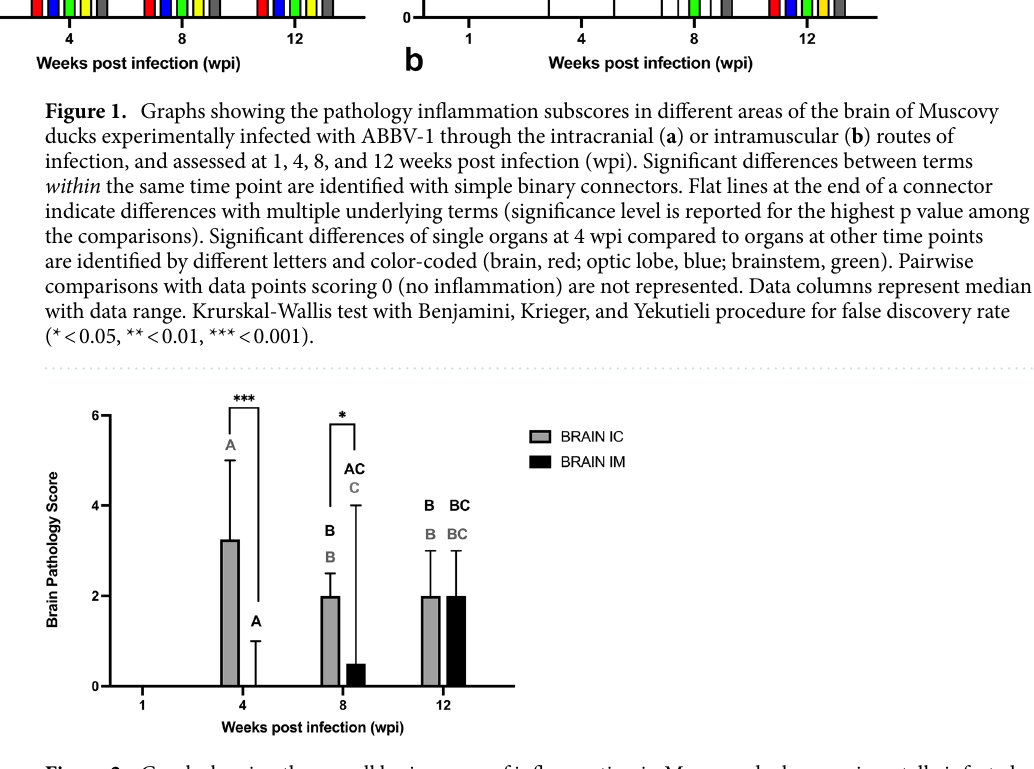
Morphology of microscopic lesions. Inflammation did not appear to target specific areas of the nervous tissue, and was characterized by accumulation of a mononuclear infiltrate that expanded the perivascular spaces in the brain and spinal cord, segmentally the meninges, and the endoneurium of the axillary or ischiatic nerves (Fig. 3a–e). Within the brain, both the grey and white matter were affected and in the spinal cord predominantly the grey matter (Fig. 3c,d). Inflammatory cells were predominately lymphocytes, with fewer macrophages, and rare plasma cells and heterophils (Fig. 3f). Immunohistochemistry (IHC) conducted on representative duck brains (n = 3) from the IC group at 12 wpi showed that the highest percentage of the inflammatory population was composed of CD3-positive cells (T lymphocytes), with a small percentage of Pax-5-positive cells (B lym- phocytes) (Fig. 3g,h). Besides inflammation, gliosis characterized by proliferation and hypertrophy of glial cells with formation of glial nodules (Fig. 3i) was seen in 100% and 27% of IC birds at 4 and 12 wpi, respectively, and in 33% of IM birds at 8 wpi (Table 1). Inflammation was not identified in the myenteric nerves or ganglia of the gastrointestinal tract. No significant microscopic findings were identified in the other tissues from the IC and IM groups, and no lesions were identified in the birds from the PO and CO groups.